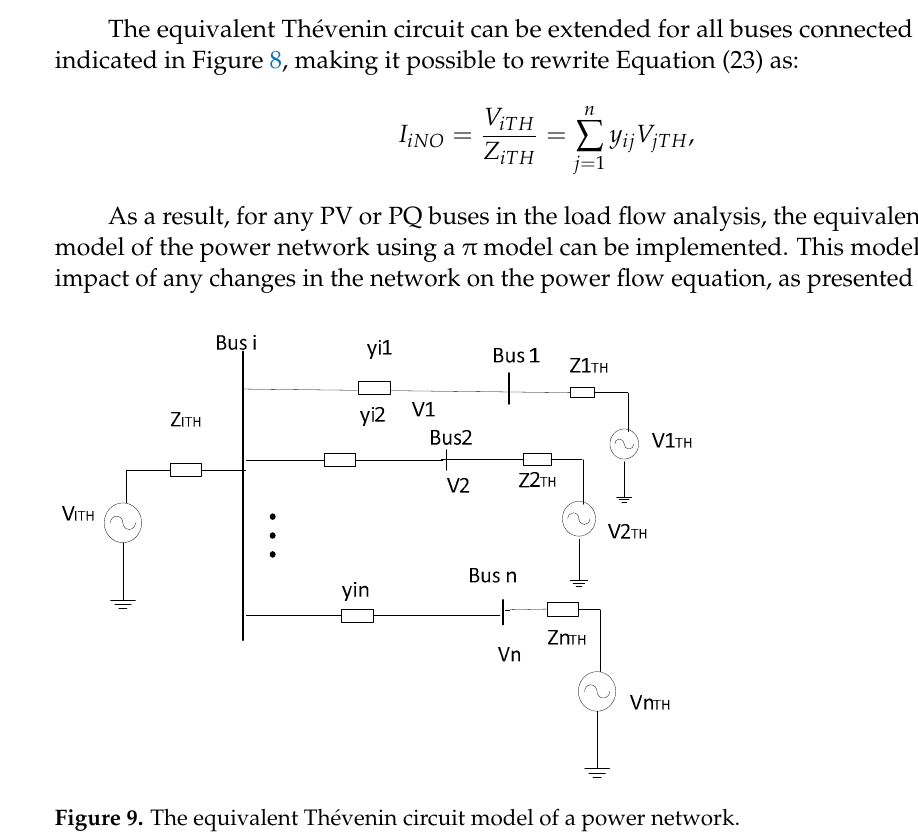
Figure 8. The equivalent Thévenin and Norton circuit models for the typical bus shown in Figure 7.